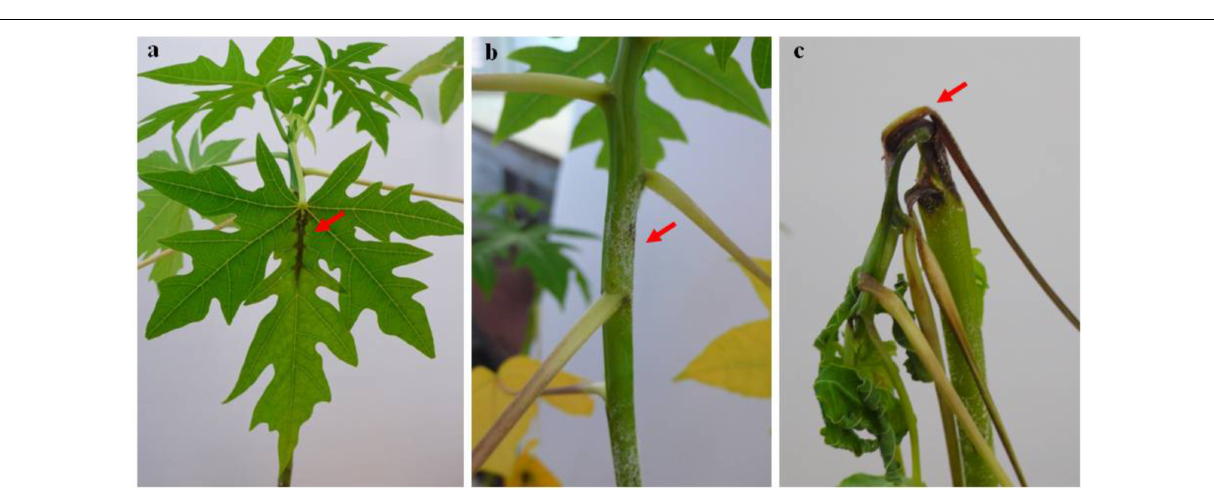
FIGURE 3 | Papaya dieback disease symptoms development on papaya seedlings artificially infected with the pathogen, Erwinia mallotivora . (a) Necrotic lesion developed along the vein of infected leaf, (b) water soaked lesion developed on infected stem, and (c) shrunken and bending of infected stem, leading to ultimate plant death. Arrows indicate the affected